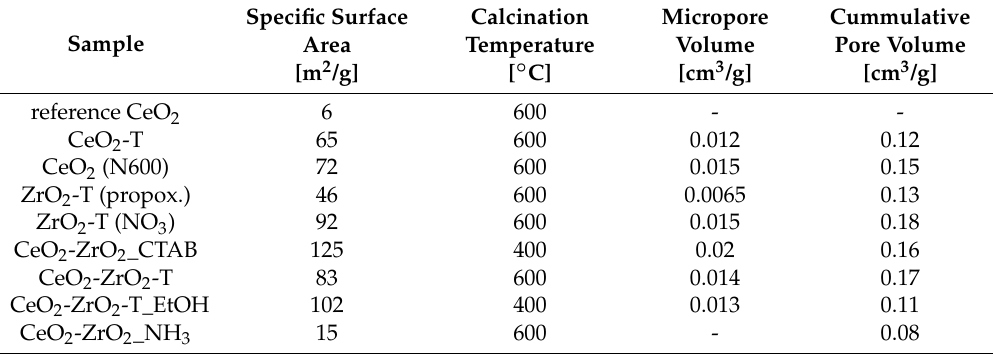
Table 2. Physicochemical properties measured by nitrogen sorption for all synthesized